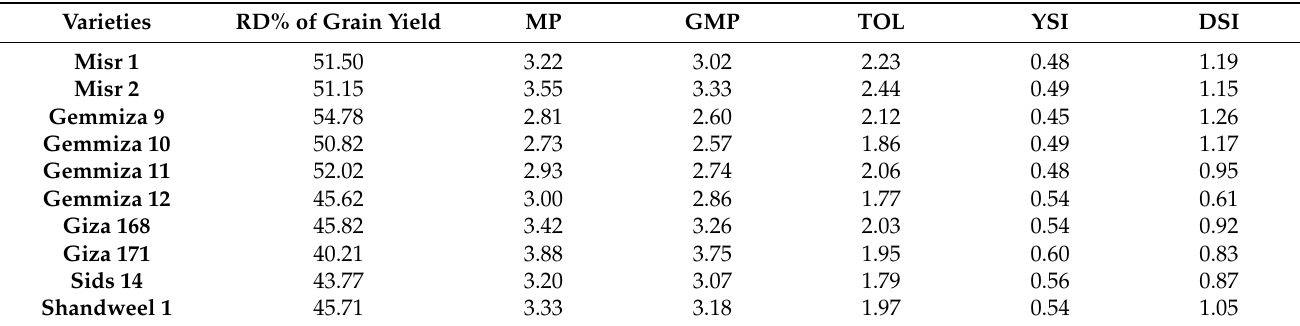
Table 5. Relative decrease (RD%), mean productivity (MP), drought susceptibility index (DSI), geometric mean of productivity (GMP), tolerance index (TOL), and yield stability index (YSI) for ten wheat cultivars.